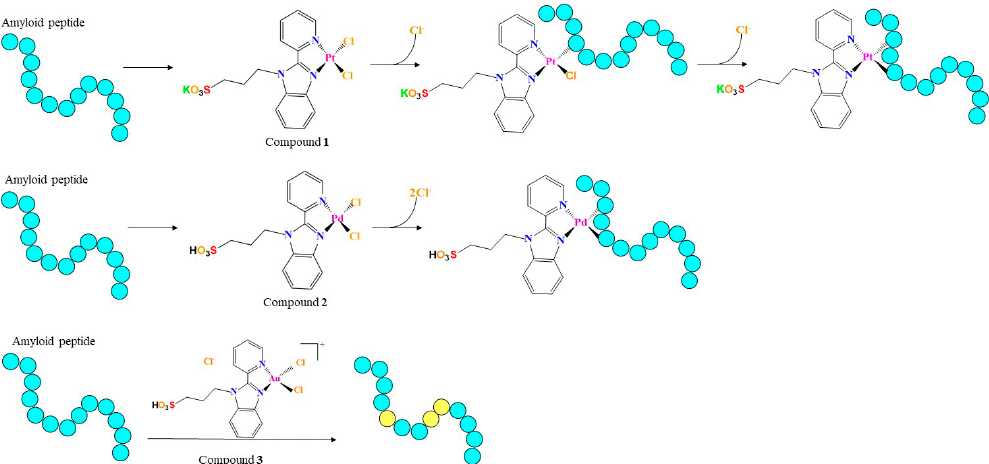
Figure 7. Schematic representation of the different mechanisms of action of compounds 1, 2, and 3 in the modulation of the aggregation of amyloid peptides analyzed in this study. Pt and Pd compounds interact with the peptides forming adducts with Pt- and Pd-containing fragments directly coordinated to residue side chains, while the Au compound does not directly interact with the peptides, but it alters the oxidation state of specific residues. In the figure, residues are indicated as cyan spheres. They are colored in yellow when present an altered oxidation